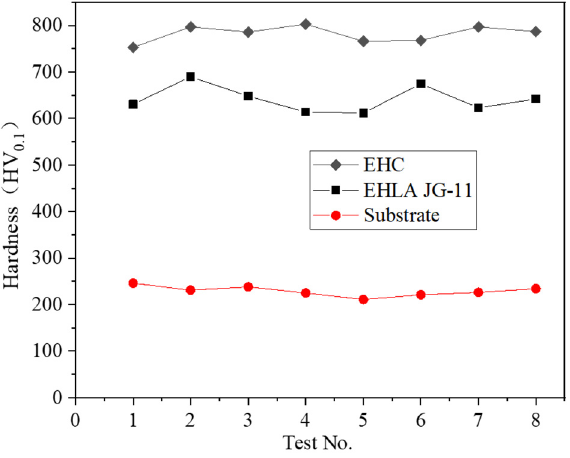
Figure 11. Microhardness of the samples.